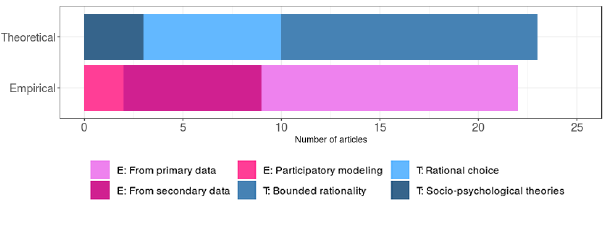
Fig. 1 . Origin of the decision-making processes used for